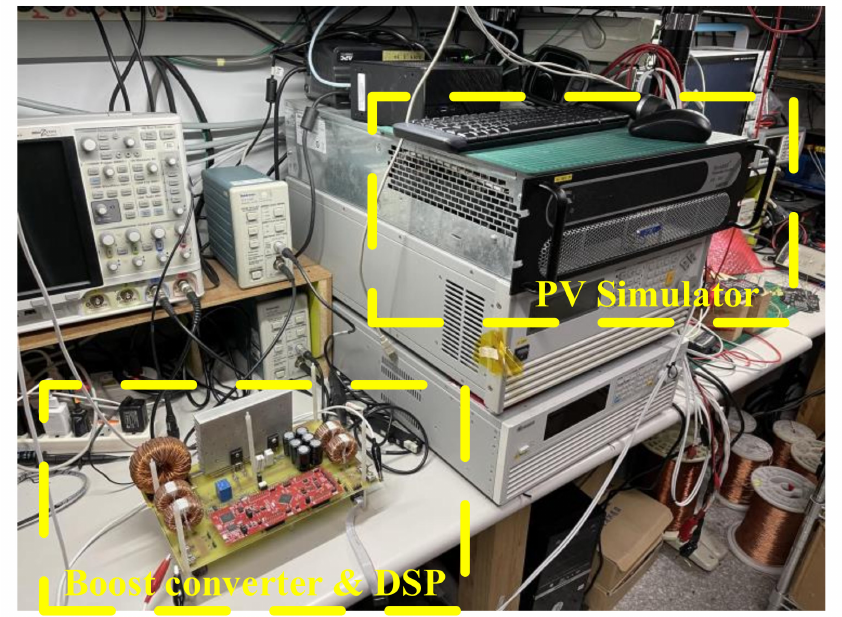
Figure 11. Experimental setup and the testing